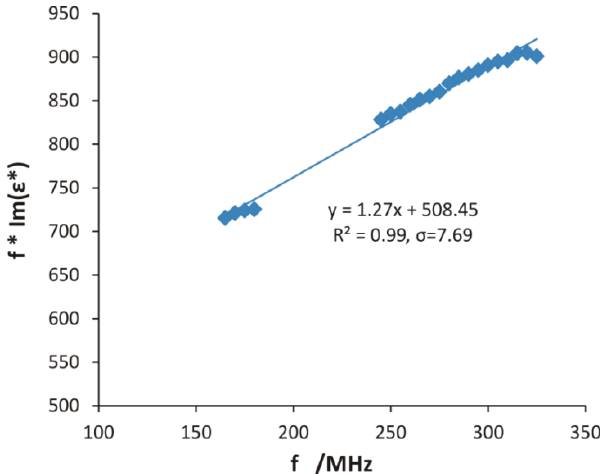
is directly proportional to the (cid:3029) is about (cid:3029)